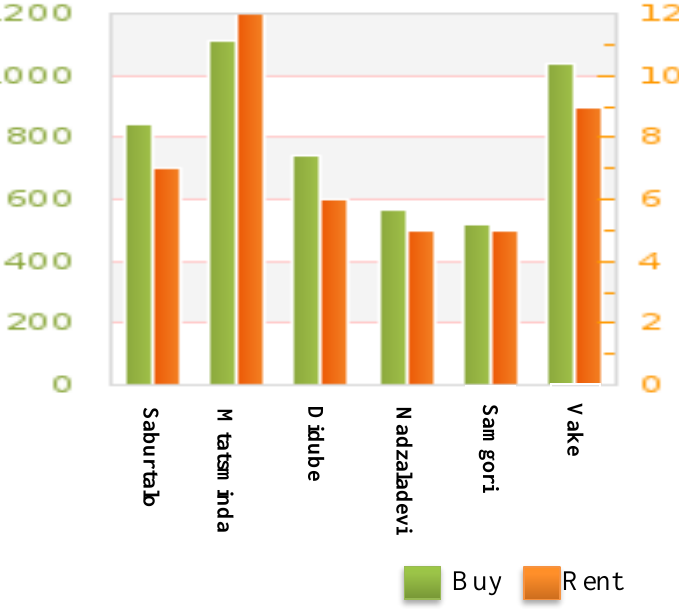
Fig. 4. Residential real estate (cost per m 2 in US dollars ($) (Makler.ge,